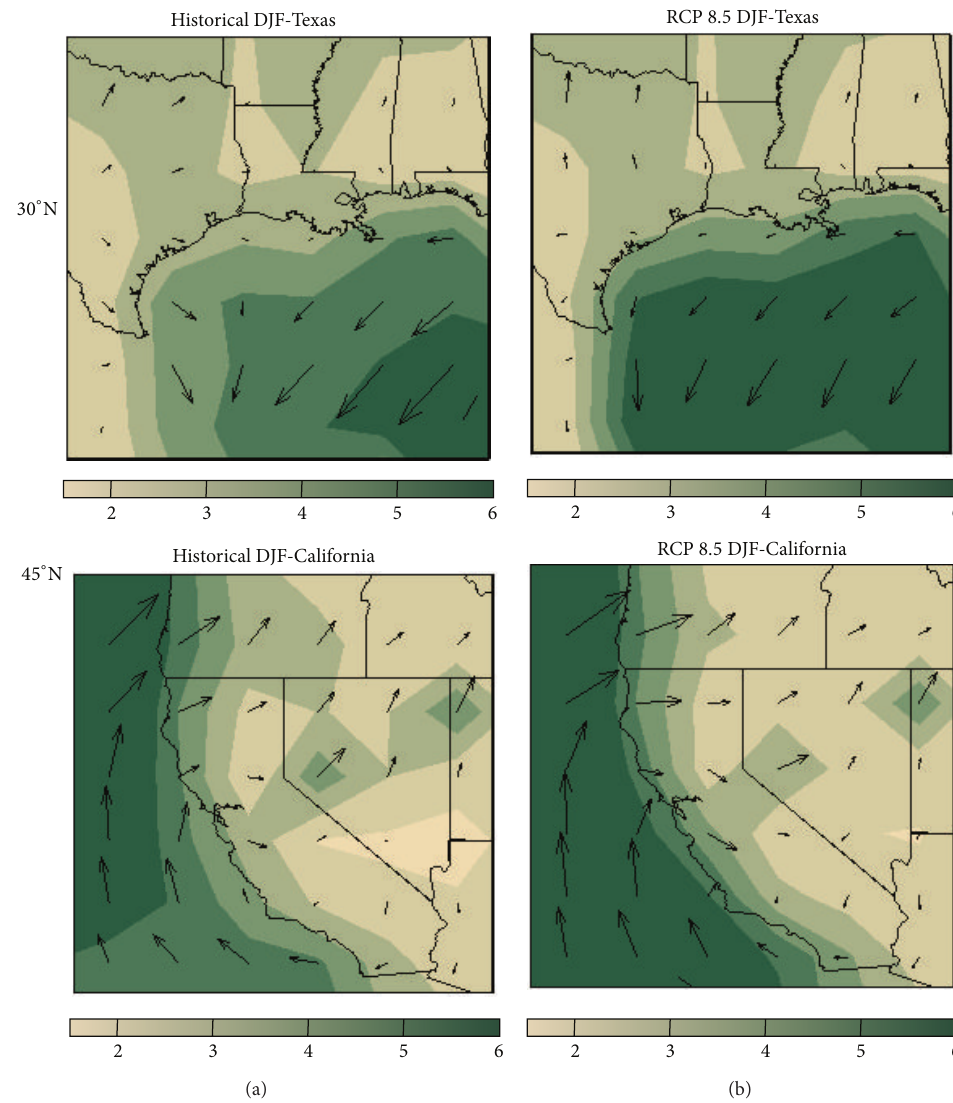
Figure 7: Similar to Figure 6 but for the surface wind fields from GISS-E2-H simulations for winter (DJF) and for two different regions. (a) and (b) are the historical and RCP 8.5 runs, respectively. Top: The Southern USA and part of Gulf of Mexico. Bottom: West Coast of the USA and off shore of